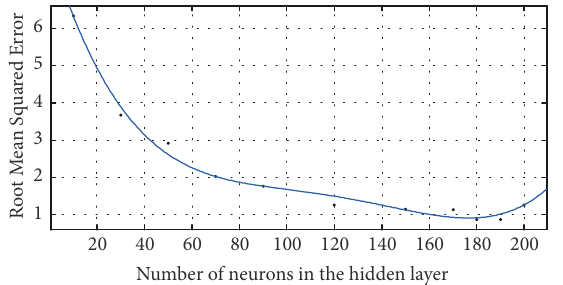
Figure 12: Root Mean Square Error (RMSE) versus number of neurons in the hidden layer (NNHL) for two inputs.